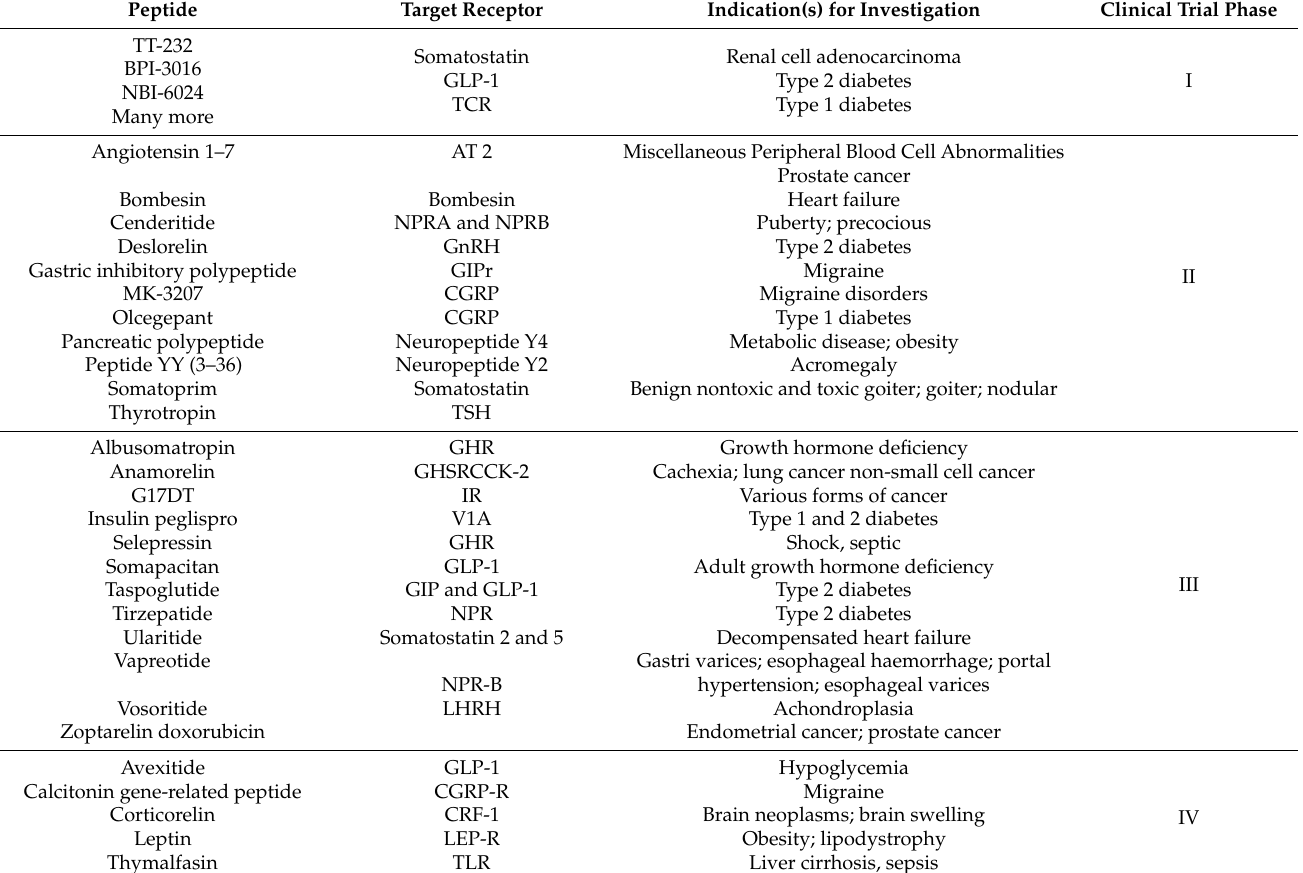
Table 2. Peptide drug candidates undergoing clinical development